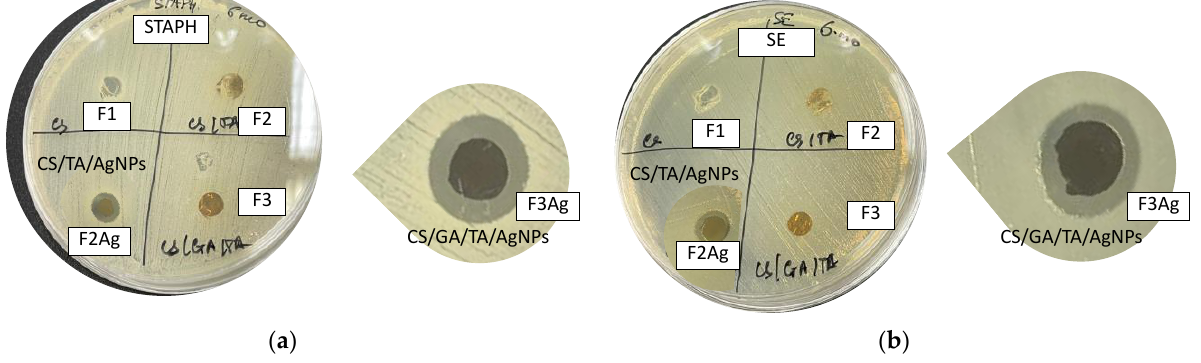
Figure 13. Results of disk diffusion tests for hybrid 6-month-aged films (F1 (CS), F2 (CS/TA), F2Ag (CS/TA/AgNPs), F3 (CS/GA/TA), F3Ag (CS/GA/TA/AgNPs) against ( a ) S. aureus and ( b ) S. enterica.